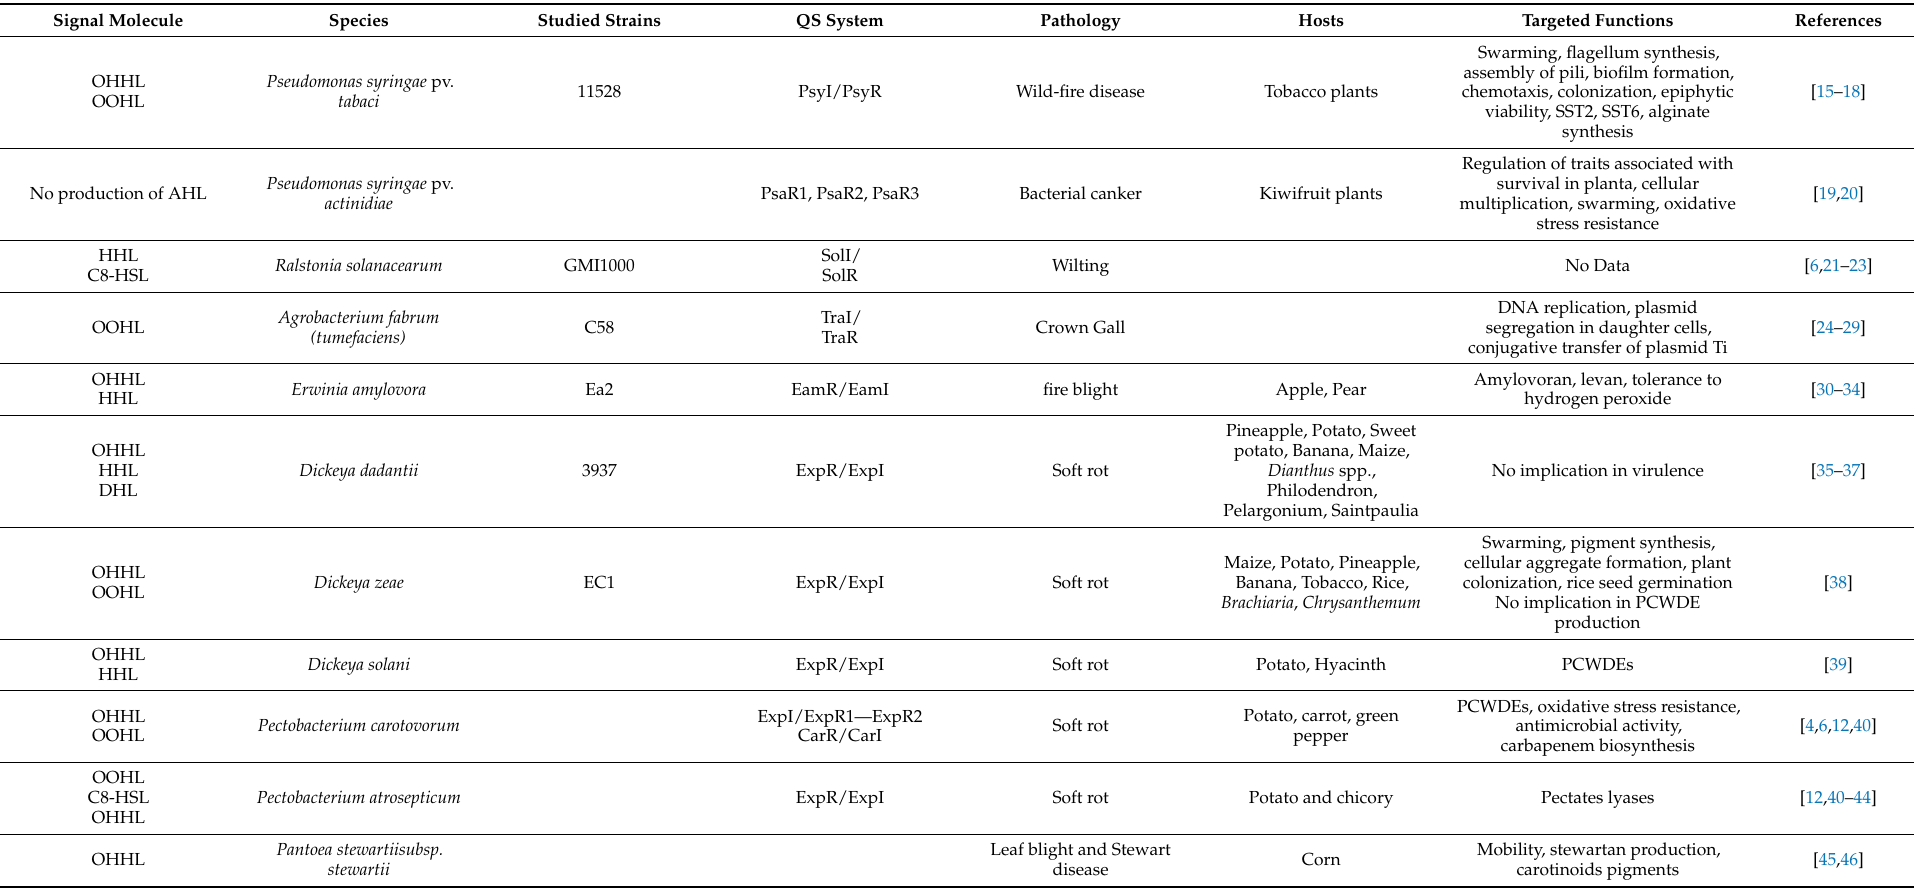
Table 2. Overview of AHL-mediated quorum sensing molecules produced by phytopathogenic